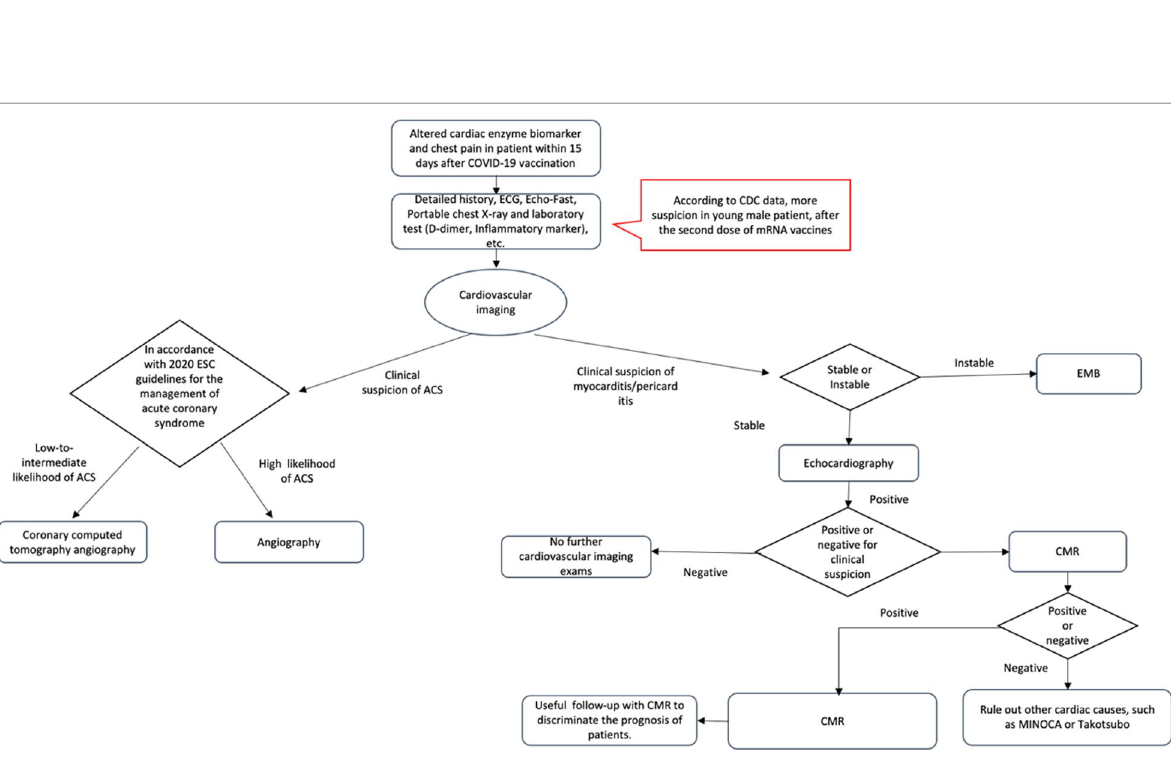
Fig. 4 Diagnostic flowchart for suspected myocardial damage post COVID-19